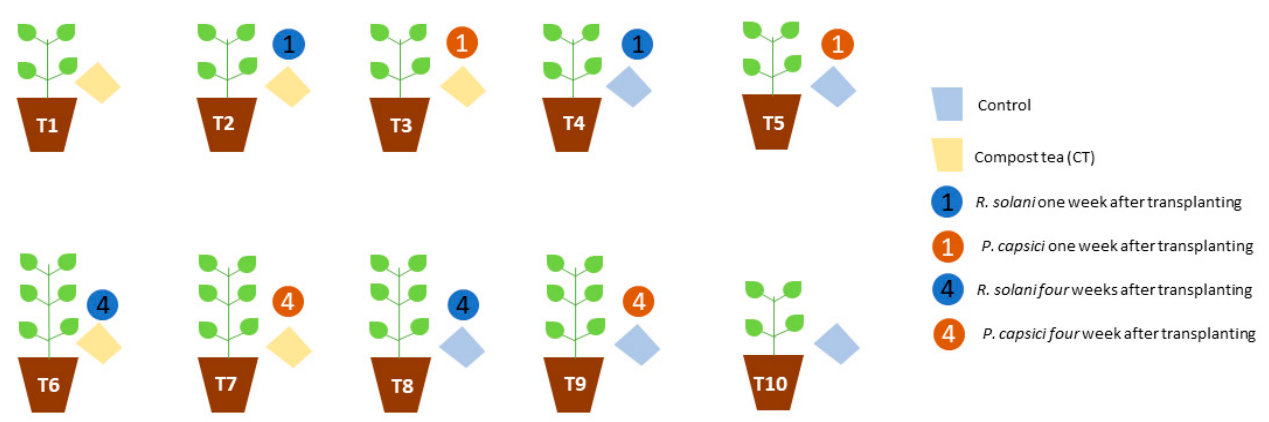
Figure 1. Summary of treatments.